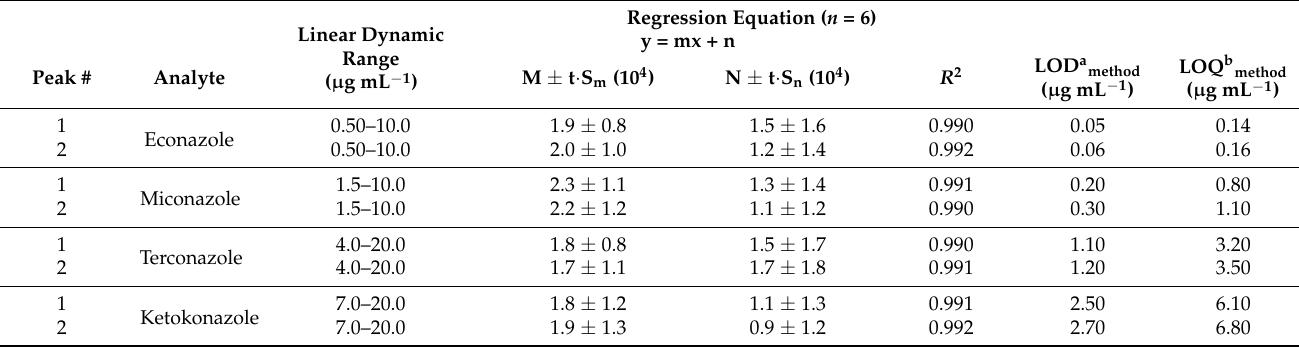
m, slope; Sm, standard deviation of the slope; n, intercept; Sn, standard deviation of the intercept; R 2 , determination coefficient. (a) Calculated as the concentration associated with an S/N ratio of 3; (b) Calculated as the concentration associated with an S/N ratio of 10. t = (Student’s t test) = 2.78, α = 0.05.